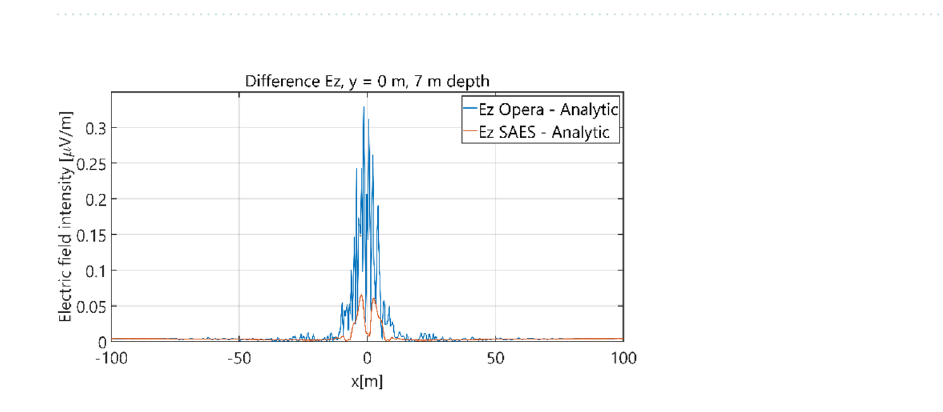
Figure 17. Distribution of differences between E y values obtained from Opera (FEM) and SAES (BEM) models and the analytical model ( y = 15 m, z = − 7 m, case I).